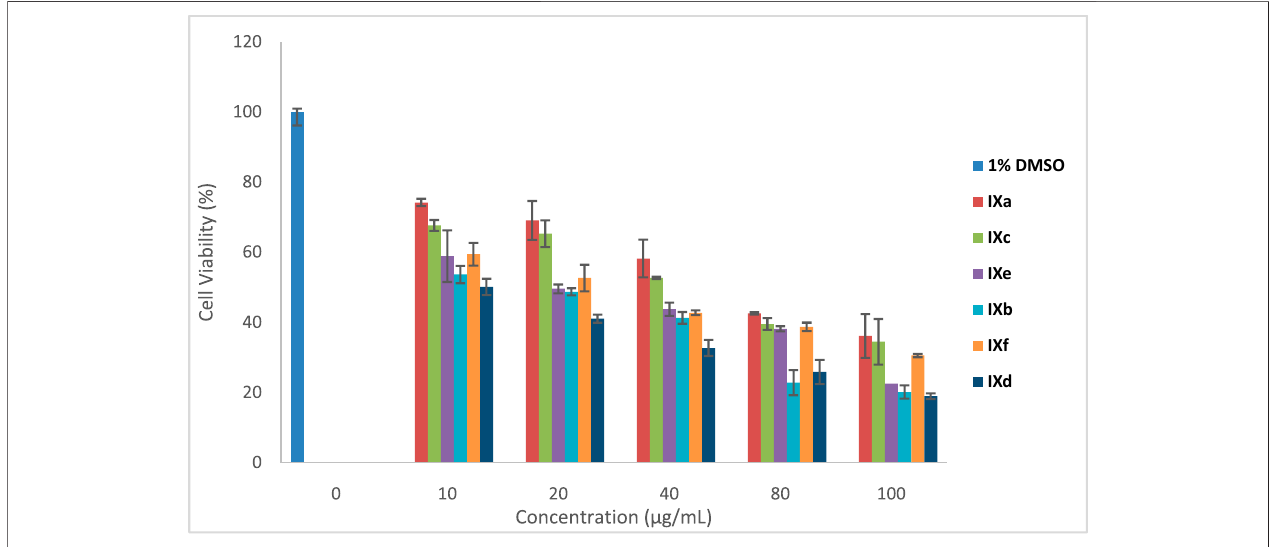
FIGURE 10 | PDT for Pcs at 0, 10, 20, 40, 80, and 100 μ